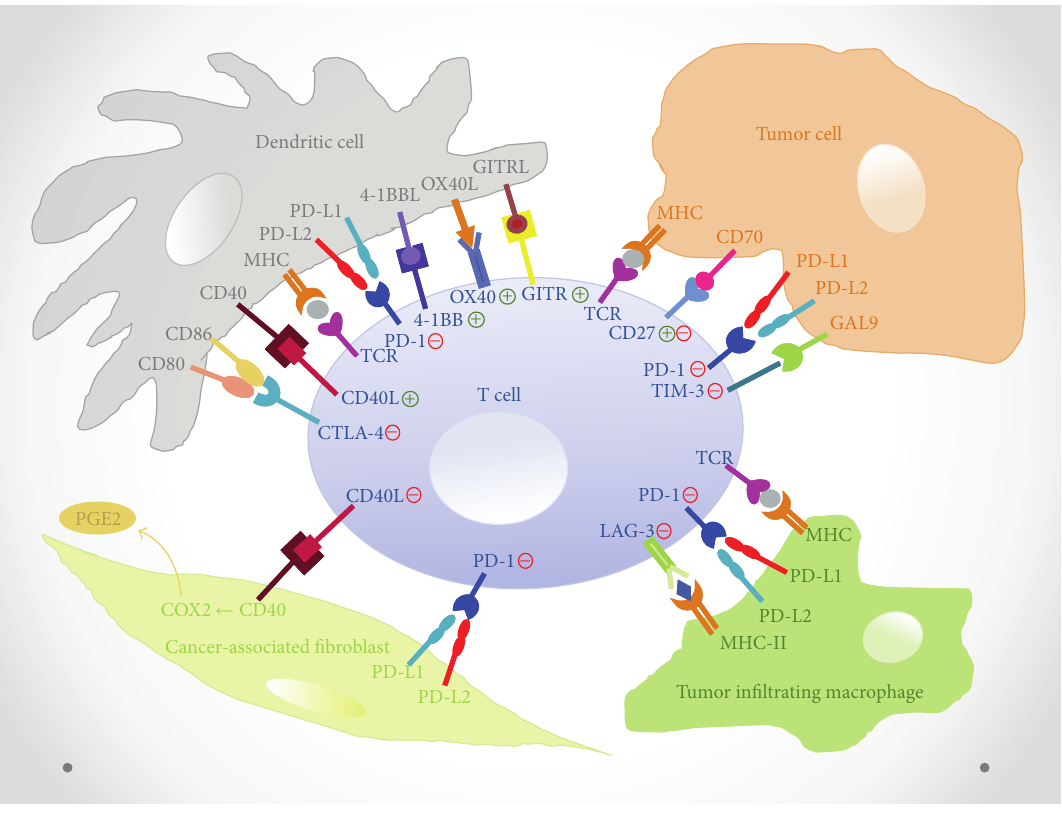
Figure 1: Overview of immune checkpoint molecules involved in CRC pathogenesis. CD, cluster of differentiation; COX2, cyclooxygenase-2; CTLA-4, cytotoxic T lymphocyte antigen-4; GAL9, Galectin-9; GITR, glucocorticoid-induced TNFR-related protein; LAG-3, lymphocyte activation gene-3; MHC, major histocompatibility complex; PD-1, programmed death-1; PD-L, programmed death ligand; PGE2, prostaglandin E2; TCR, T cell receptor; TIM-3, T cell immunoglobulin and mucin containing